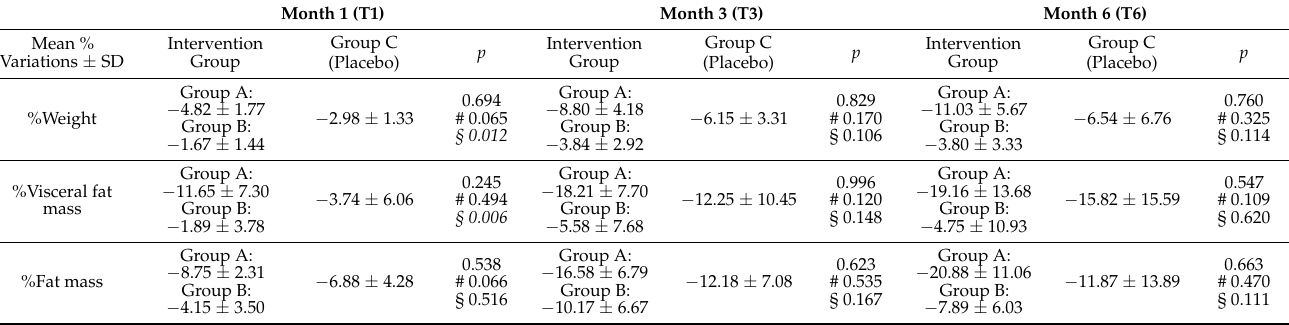
Table 7. The %weight, %visceral fat and %fat mass variations of the three groups at three